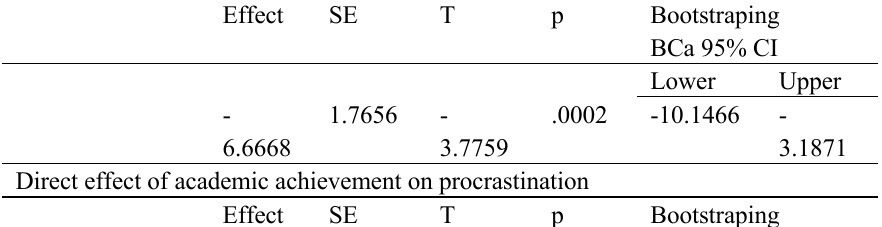
Table 4. Mediations of academic achievement on procrastination through self- efficacy and perfectionism (standards, order and discrepancy) Total effect of academic achievement on